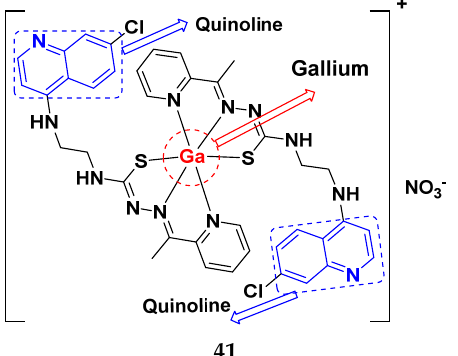
Figure 45. Quinoline ‐ based gallium(III) hybrid ( 41 ). Quinoline ‐ Based FDA Approved Drugs Quinoline containing drugs that have received FDA approval include lenvatinib, cabozantinib, and bosutinib which are protein kinase inhibitors and are used to cure me ‐ dullary thyroid cancer and chronic myelogenous leukemia accordingly. FDA approved drugs with quinoline hybrids are depicted in Figure 46 and their details are shown in Table 34. Cabozantinib